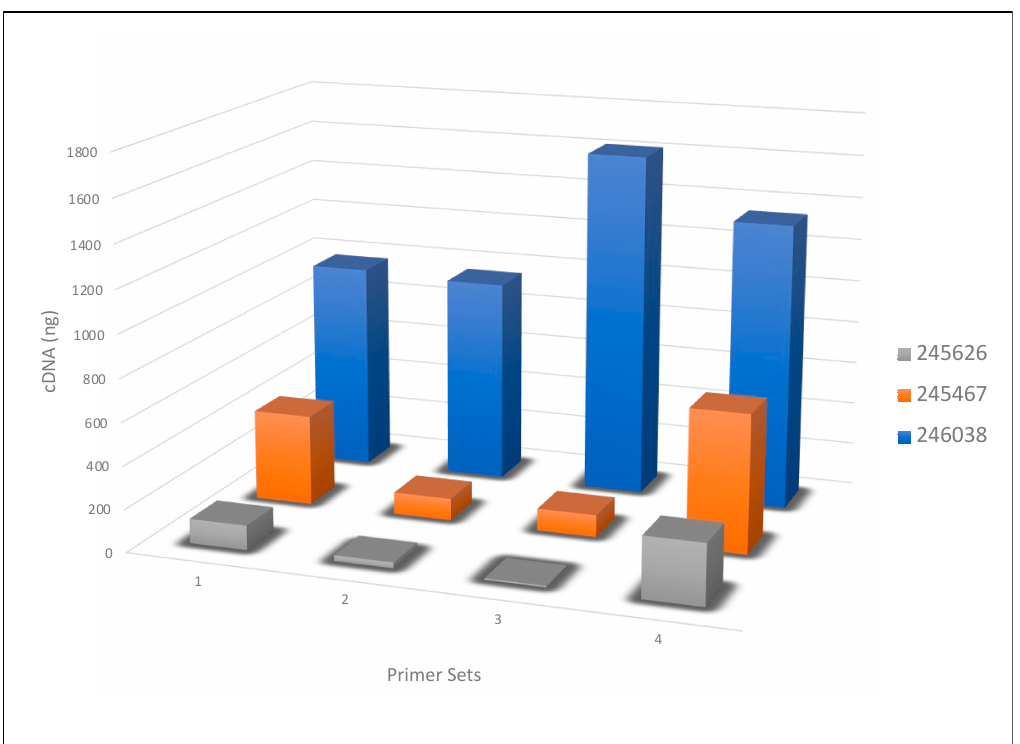
Figure 1. Net cDNA generated with four primer sets. The amount, in nanograms, of cDNA recovered following bead purification of the SuperScript III RT-PCR reaction on the three HPAI H5N1 swab samples is shown on the Y axis. Primer sets used (1–4, see Table 2) are listed on the X axis and the RNA samples used (from Table 1) are listed in the figure legend.